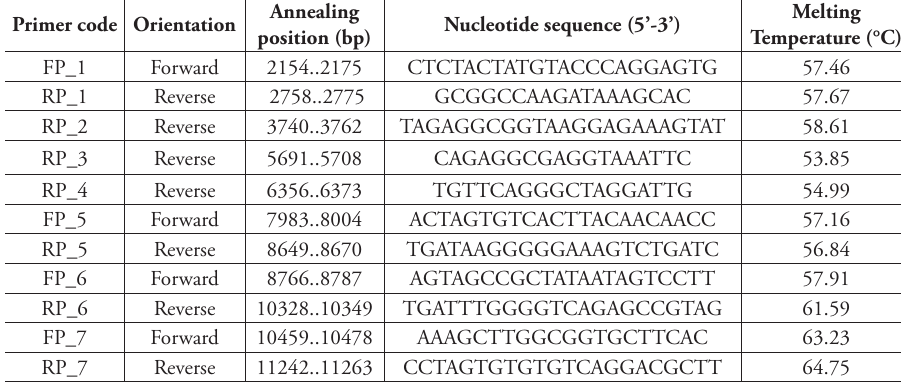
Table 1. Details of the primers used to amplify the mitochondrial DNA of P. corethrurus . Primer code Orientation